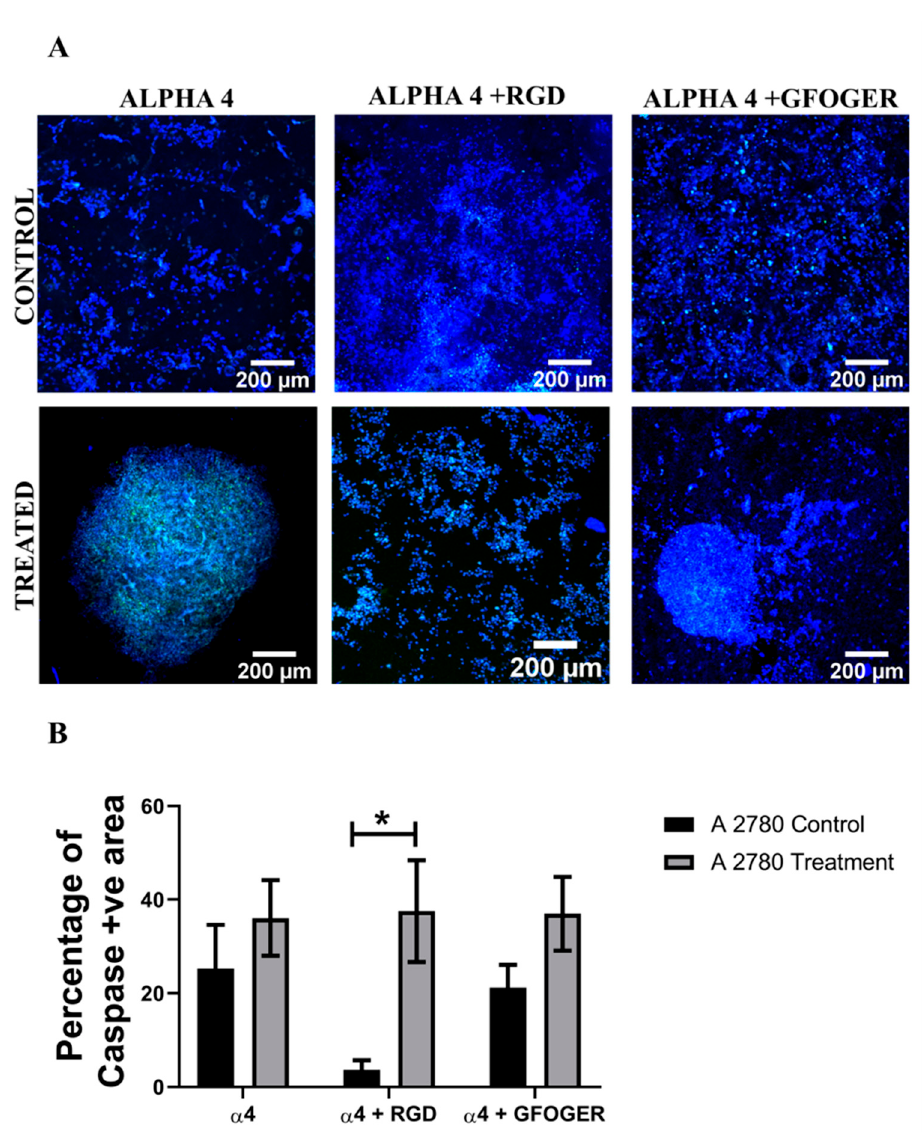
Figure 5. Effect of the chemotherapeutic Cisplatin on the apoptosis of A2780 EOC cells grown in different PeptiGels, 24 h post-treatment ( A ): Representative images for caspase 3/7 (apoptosis)–DAPI (green–blue) staining for both treated and untreated (control) A2780 PeptiGels. ( B ) Image analysis-based quantification of apoptotic (green) image areas for A2780 cells grown in the PeptiGels. Scale bar = 200 µ m. Quantitative data represent mean ± SEM for multiple images ( ≥ 3) and multiple hydrogels ( ≥ 3). * p ≤ 0.05 .